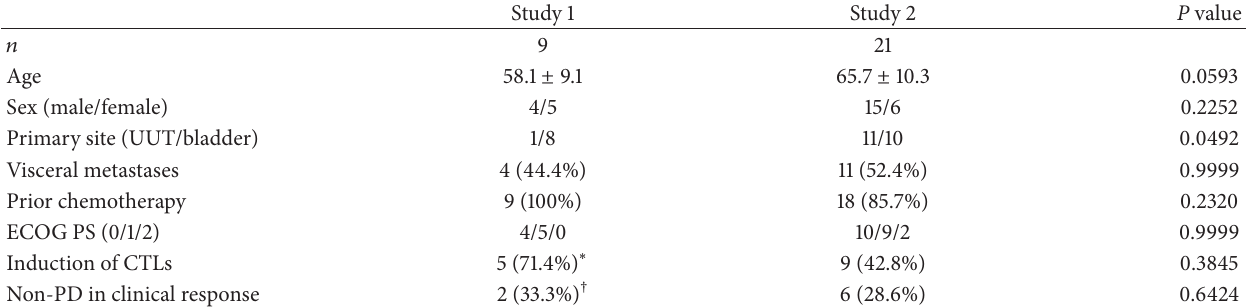
Table 3: Baseline characteristics and immunological responses in Study 1 and Study 2.